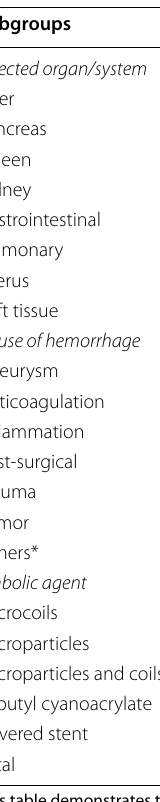
Table 3 Subgroup